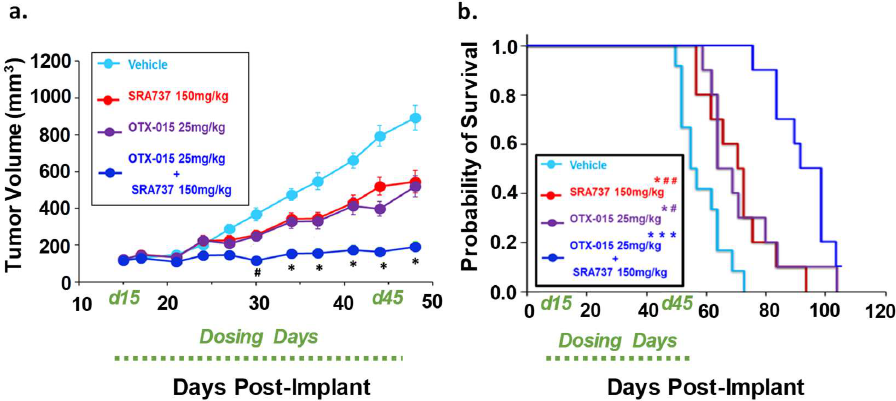
Figure 9. Combination therapy targeting BET and CHK1 significantly inhibited initial tumor growth